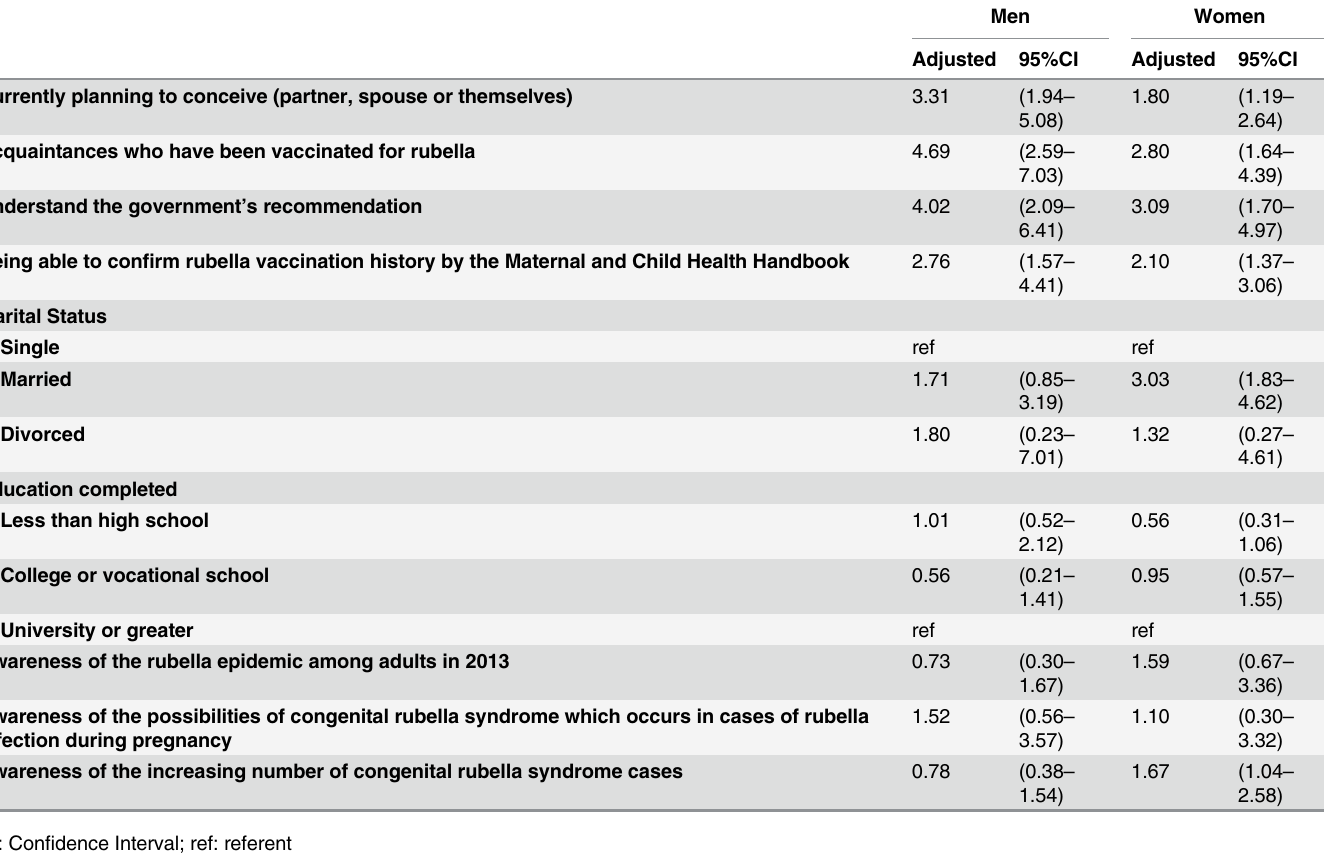
Table 3. Logistic regression analysis regarding vaccination or antibody testing for rubella during 2013 in Japan (Men and